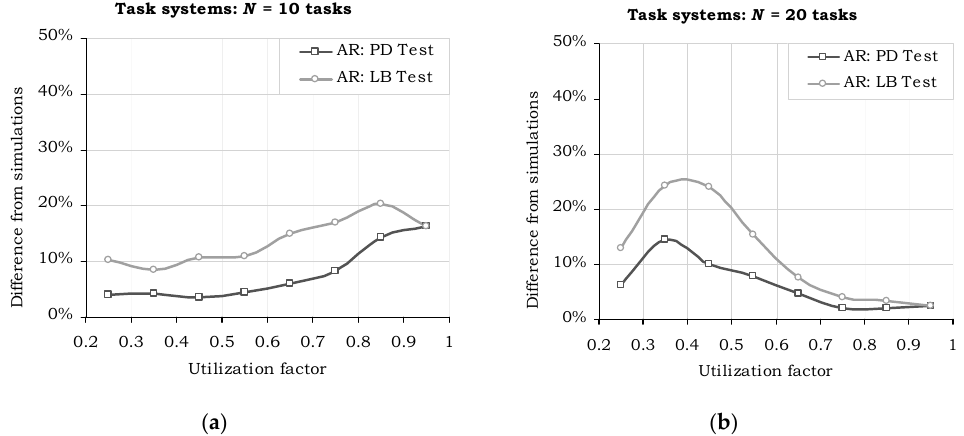
Figure 6. Difference between the simulation results and the acceptance test results, at various total utilization factors. ( a ) N = 10 tasks, ( b ) N = 20 tasks.